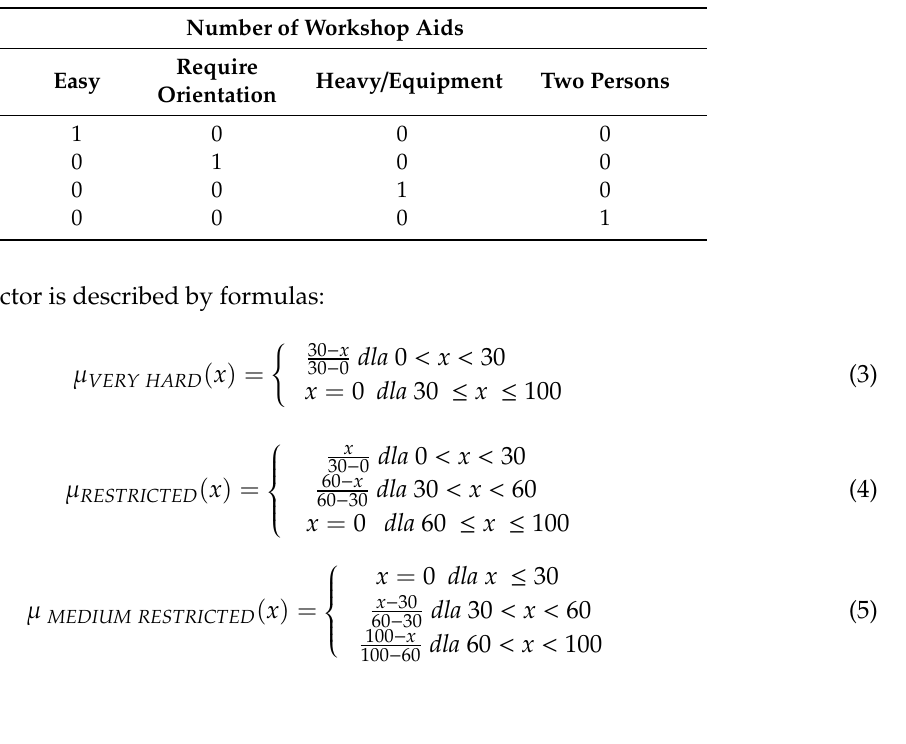
Table 5. Rules database for “number of workshop